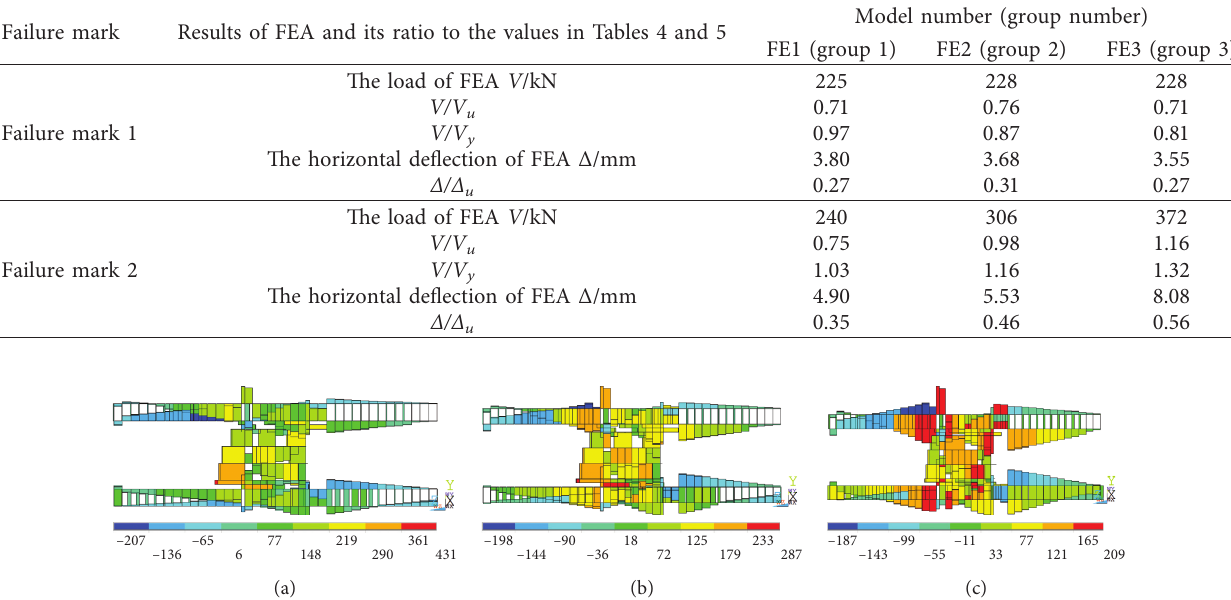
Figure 27: The stress distribution of steel bar under failure mark 1. (a) The steel bar of FE1. (b) The steel bar of FE2. (c) The steel bar of FE3.